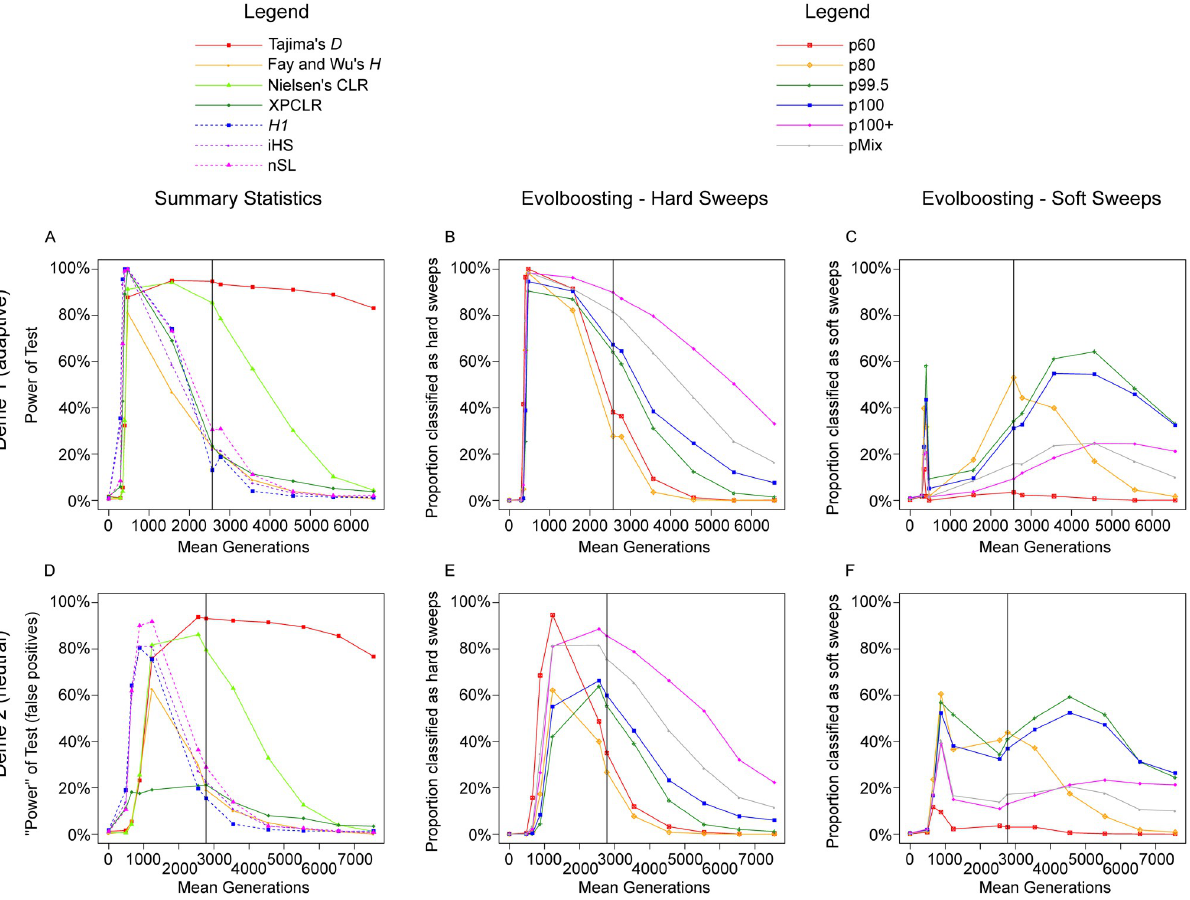
Fig 7. Full-locus simulation: The detection rate of various methods in a local adaptation scenario. The proportion of samples detected as selective sweeps by various methods, under the scenario m 20 L . The vertical line indicates time of 100% fixation. A. Power of seven summary statistics in d 1 ; dashed lines indicate haplotype-based methods. B. Proportion detected by six EvolBoosting predictors correctly as hard sweeps in d 1 . C. Proportion detected by six EvolBoosting predictors incorrectly as soft sweeps in d 1 . D. False positive rate of seven summary statistics in d 2 . E. Proportion detected by six EvolBoosting predictors incorrectly as hard sweeps in d 2 . F. Proportion detected by six EvolBoosting predictors incorrectly as soft sweeps in d 2 . See S3 Fig for a zoomed-in version for early stages.